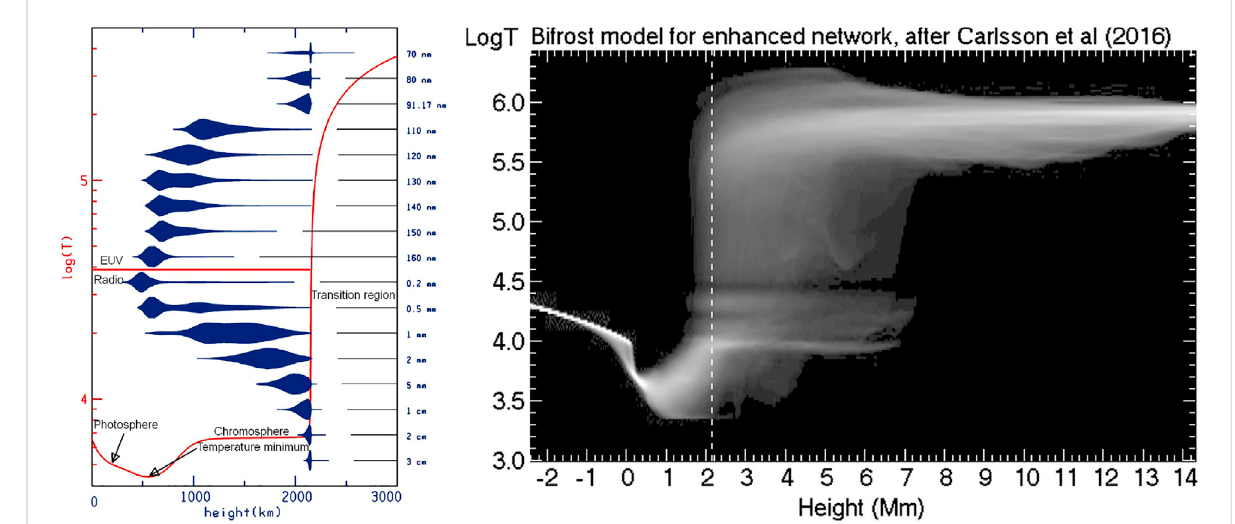
FIGURE 1 Thetemperatureasafunctionofheightandtheformationheightofmm- λ emission(Left)Theelectrontemperatureasafunctionofheight(red line) according to model C7, adapted from Avrett and Loeser (2008). The contribution to the continuum intensity is plotted in blue for wavelengths 0.2 – 30 mm (below the red horizontal line) and the extreme ultraviolet wavelengths, marked at the right. (Right) Probability density function of the temperature as a function of height from Bifrost simulations of an enhanced network region. The vertical dashed line is at 2.14 Mm. Adapted from the lower panel of fi gure 10 of Carlsson et al.